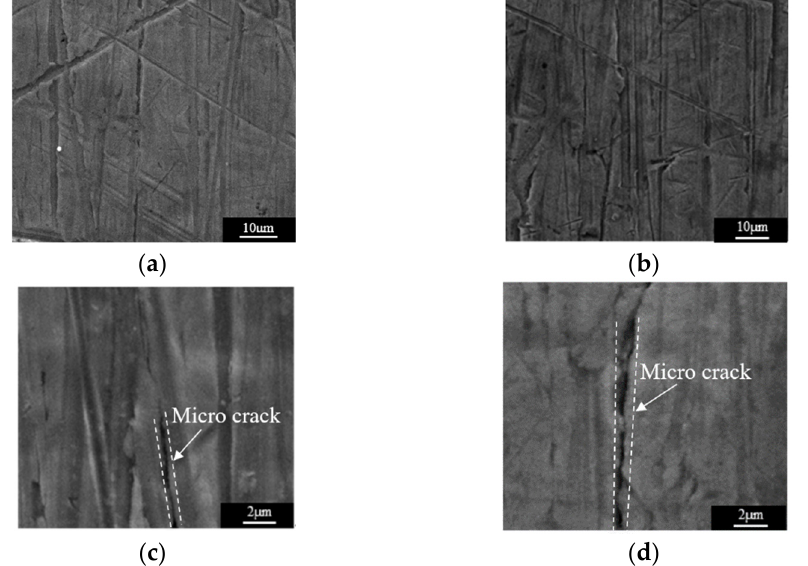
Figure 12. The SEM photographs of the SLM 316L stainless steel specimens subjected to different fatigue cycles. ( a ) Specimen C1 (10,000 times). ( b ) Specimen C2 (20,000 times). ( c ) Specimen C1 (30,000 times). ( d ) Specimen C2 (40,000 times).